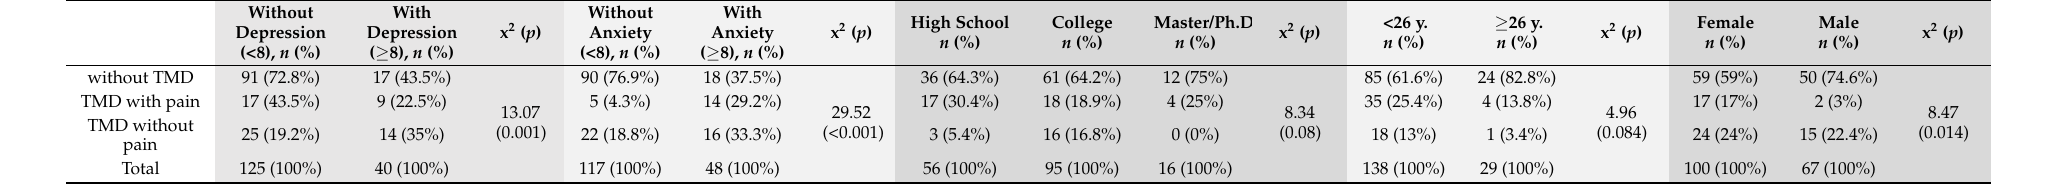
Table 7. Association between TMD and depression/anxiety/academic